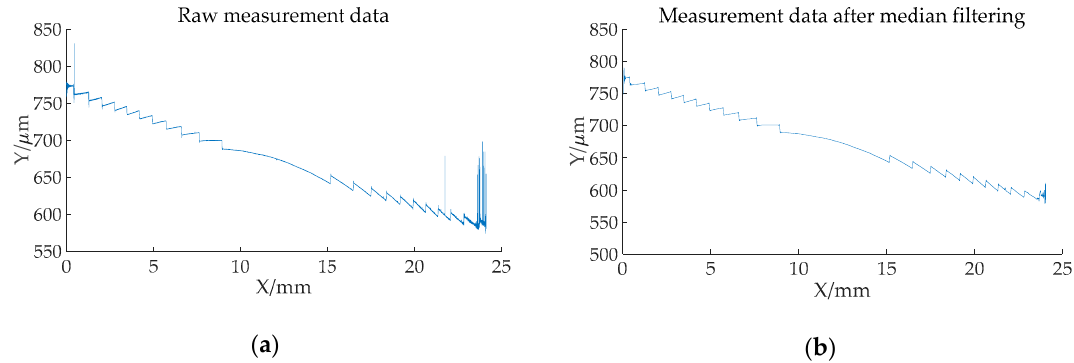
Figure 4. Measured data filtering. ( a ) Before filtering; ( b ) after filtering.